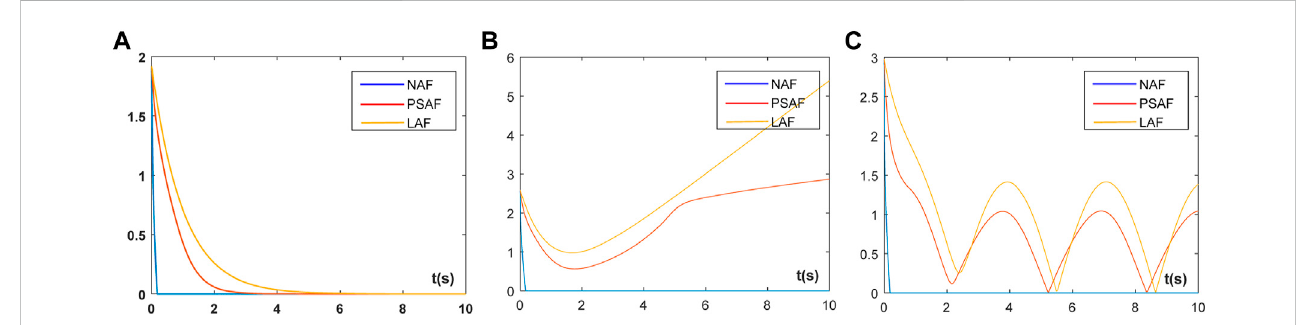
FIGURE 2 Residual graphs generated by the three activation function: (A) Simulated residual errors of ZNN for solving SDSE without noise; (B) Simulated residual errors of ZNN for solving SDSE with y(t) = 0.3t; (C) Simulated residual errors of ZNN for solving SDSE with y(t) = cos(t).